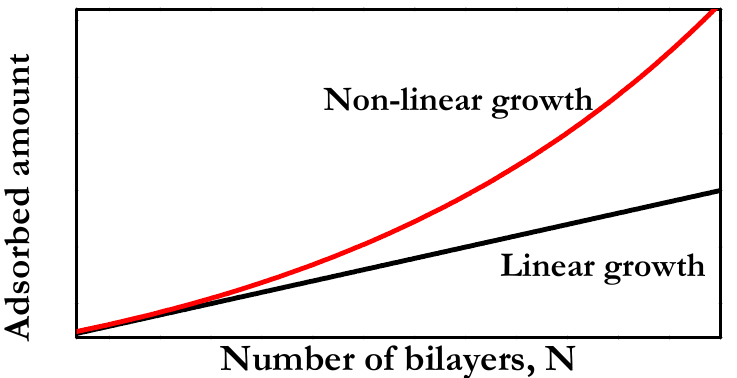
Figure 1. Sketch showing an idealization of the linear and non-linear trends of polyelectrolyte multilayers as the dependence of the adsorbed amount on the number of bilayers, N.